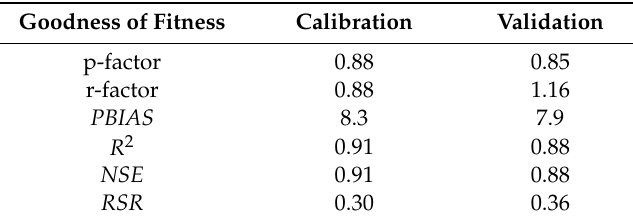
Table 4. Model statistics for calibration and